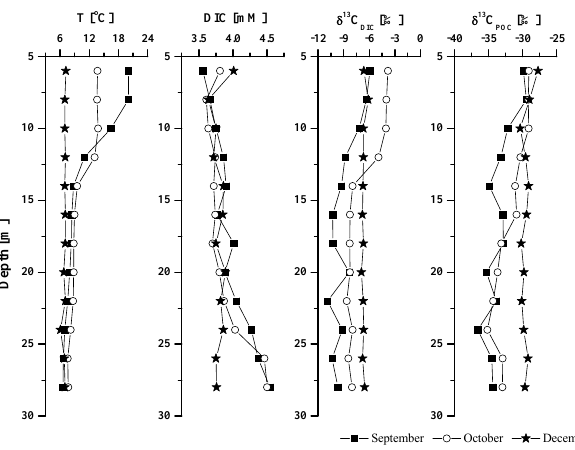
Fig. 2. Depth profiles of temperature ( T ), concentration of dis- Figure 2 solved inorganic carbon (DIC), and isotope composition of dis- solved inorganic and particulate carbon ( δ 13 C DIC ,δ 13 C POC ) in the water column during September to December 2009 at sampling point D.